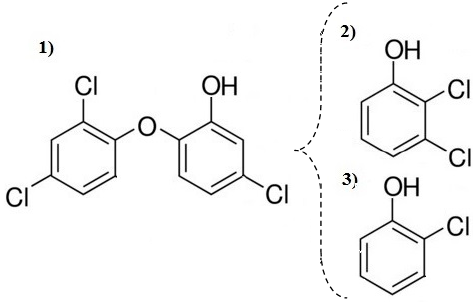
Figure 11. Identified 1 triclosan by-products, where 2 is 2,3-dichlorophenol and 3 is chlorophenol.